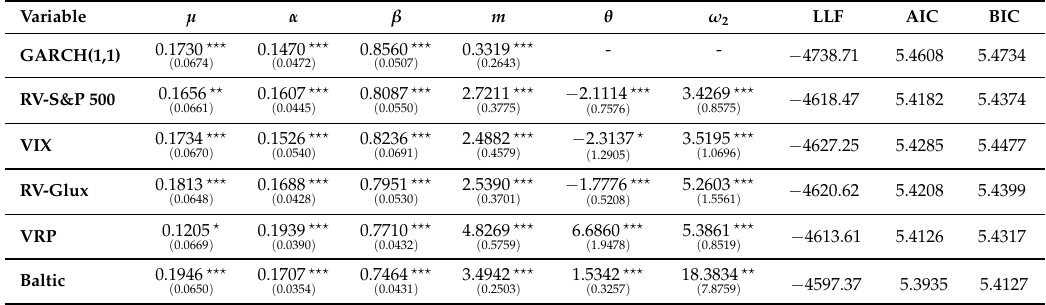
Table 3. GARCH-MIDAS for Bitcoin: financial and macroeconomic explanatory variables.